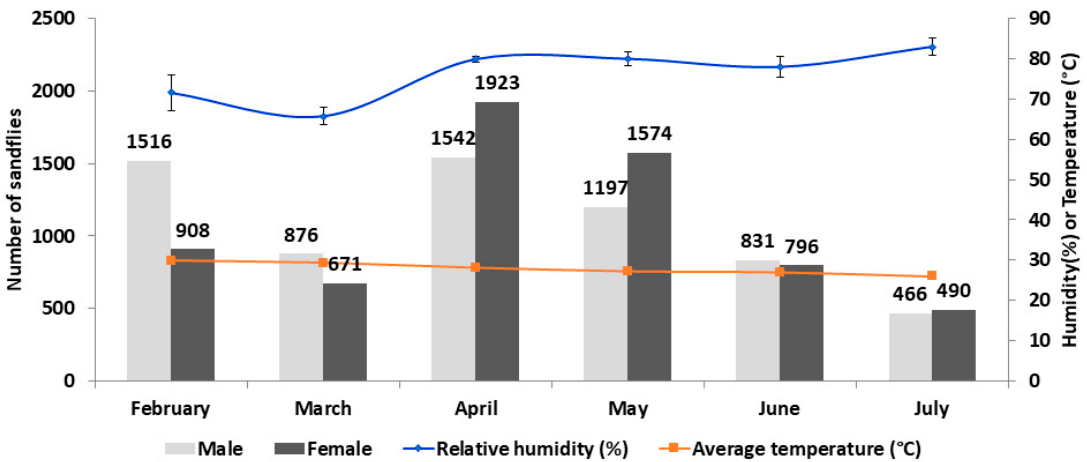
Figure 3. Monthly number of collected sandflies. The monthly number of male (grey bars) and female (black bars) sandflies is presented with the relative humidity (blue line) and average temperature (red line).